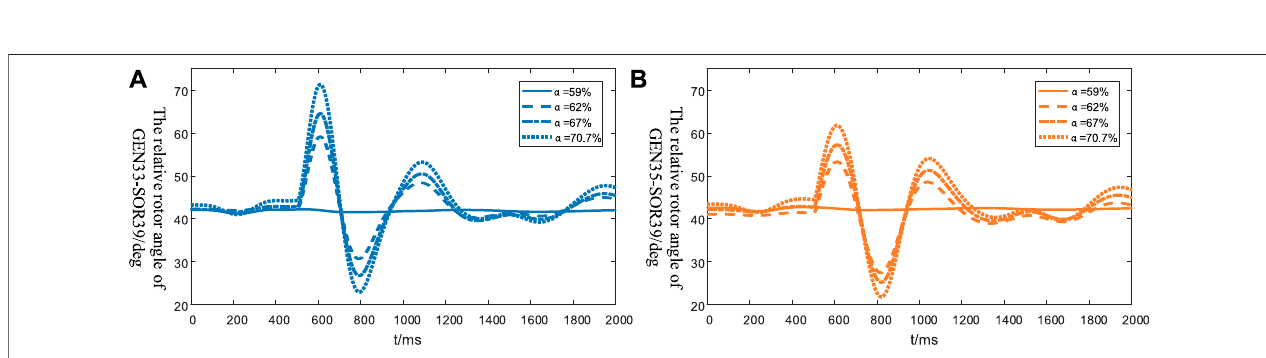
FIGURE 12 | The relative angle curve under different DC power transmission ratio (A) The relative angle curve of GEN_33-SOR_39 (B) The relative angle curve of GEN_35-SOR_39.